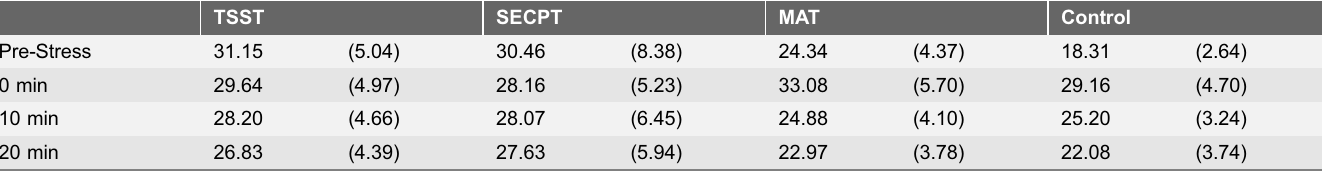
Table 5. Salivary alpha amylase (AA) as a function of stress (means and SE) at baseline and 0-, 10- and 20-minutes